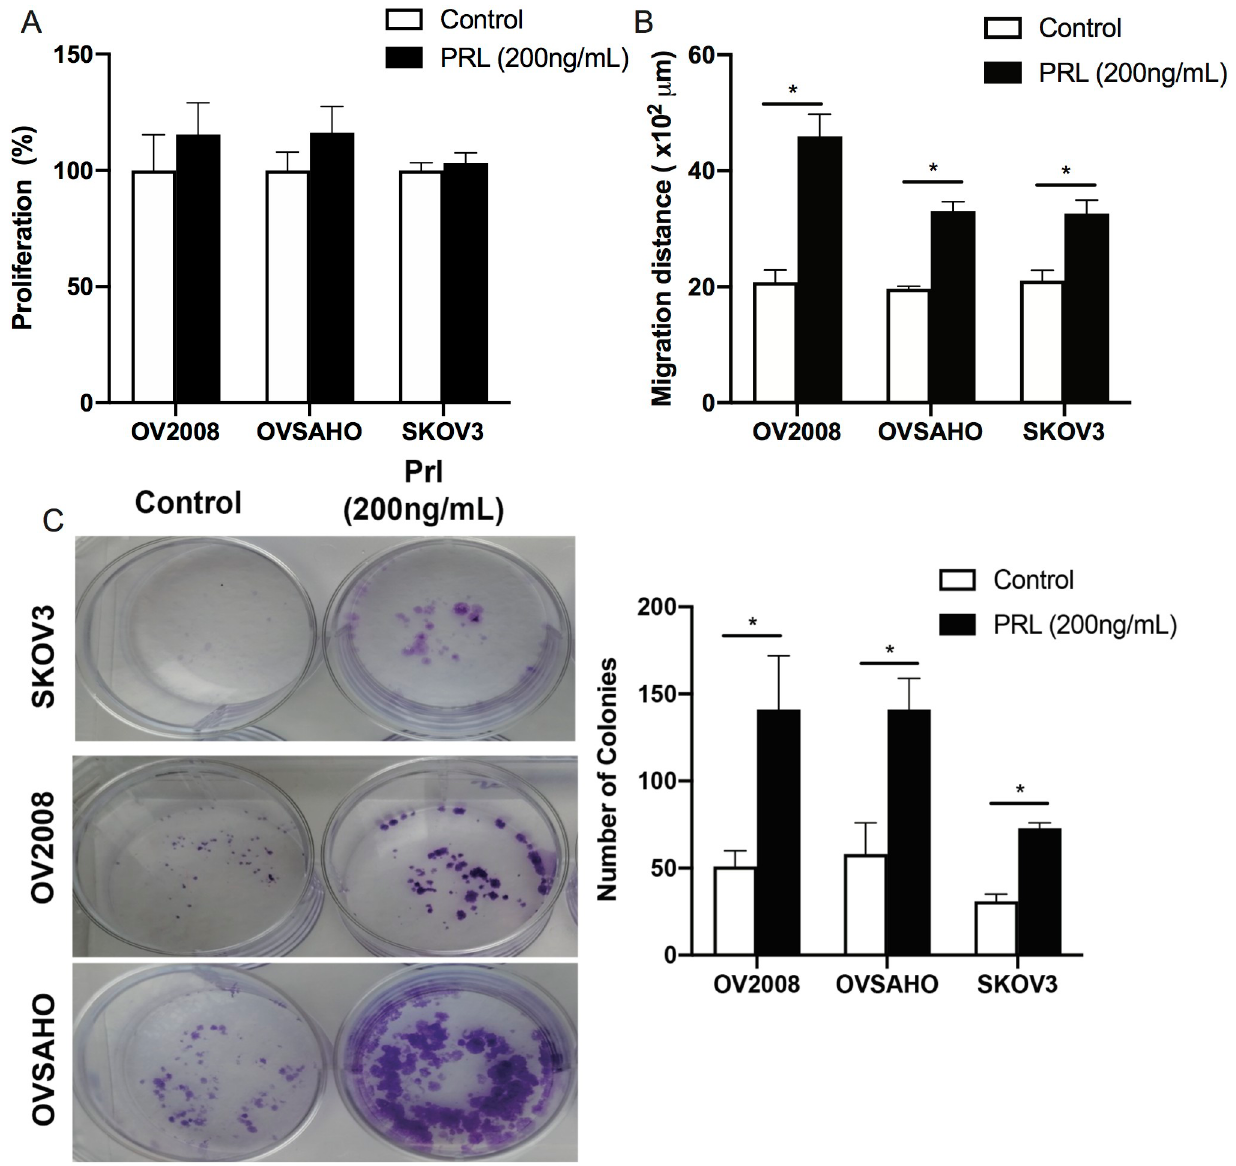
Fig 6. Effect of PRL on biological functions of ovarian cancer cells A) Effect of PRL on OV2008, OVSAHO, and SKOV3 cell proliferation. Proliferation was assessed by Alamar Blue staining after 48 hours treatment with 200 ng/ml human PRL. B) Effect of PRL on migration of ovarian cells using so called scratch assay or wound healing assay. OV2008, OVSAHO, and SKOV3 cells were cultured with 200 ng/ml PRL under serum free conditions in 12 well plates for 48 h. The migratory capacity of all cells was measured by measuring the healing distance in μ m. C) Colony forming ability of OC cell lines using colony formation assay. Results represent the means ± SE from three independent experiments. A representative photo image is shown for colonies. All data were analysed by one-way ANOVA followed by Tukey post-hoc test. � = P-value < 0.05.